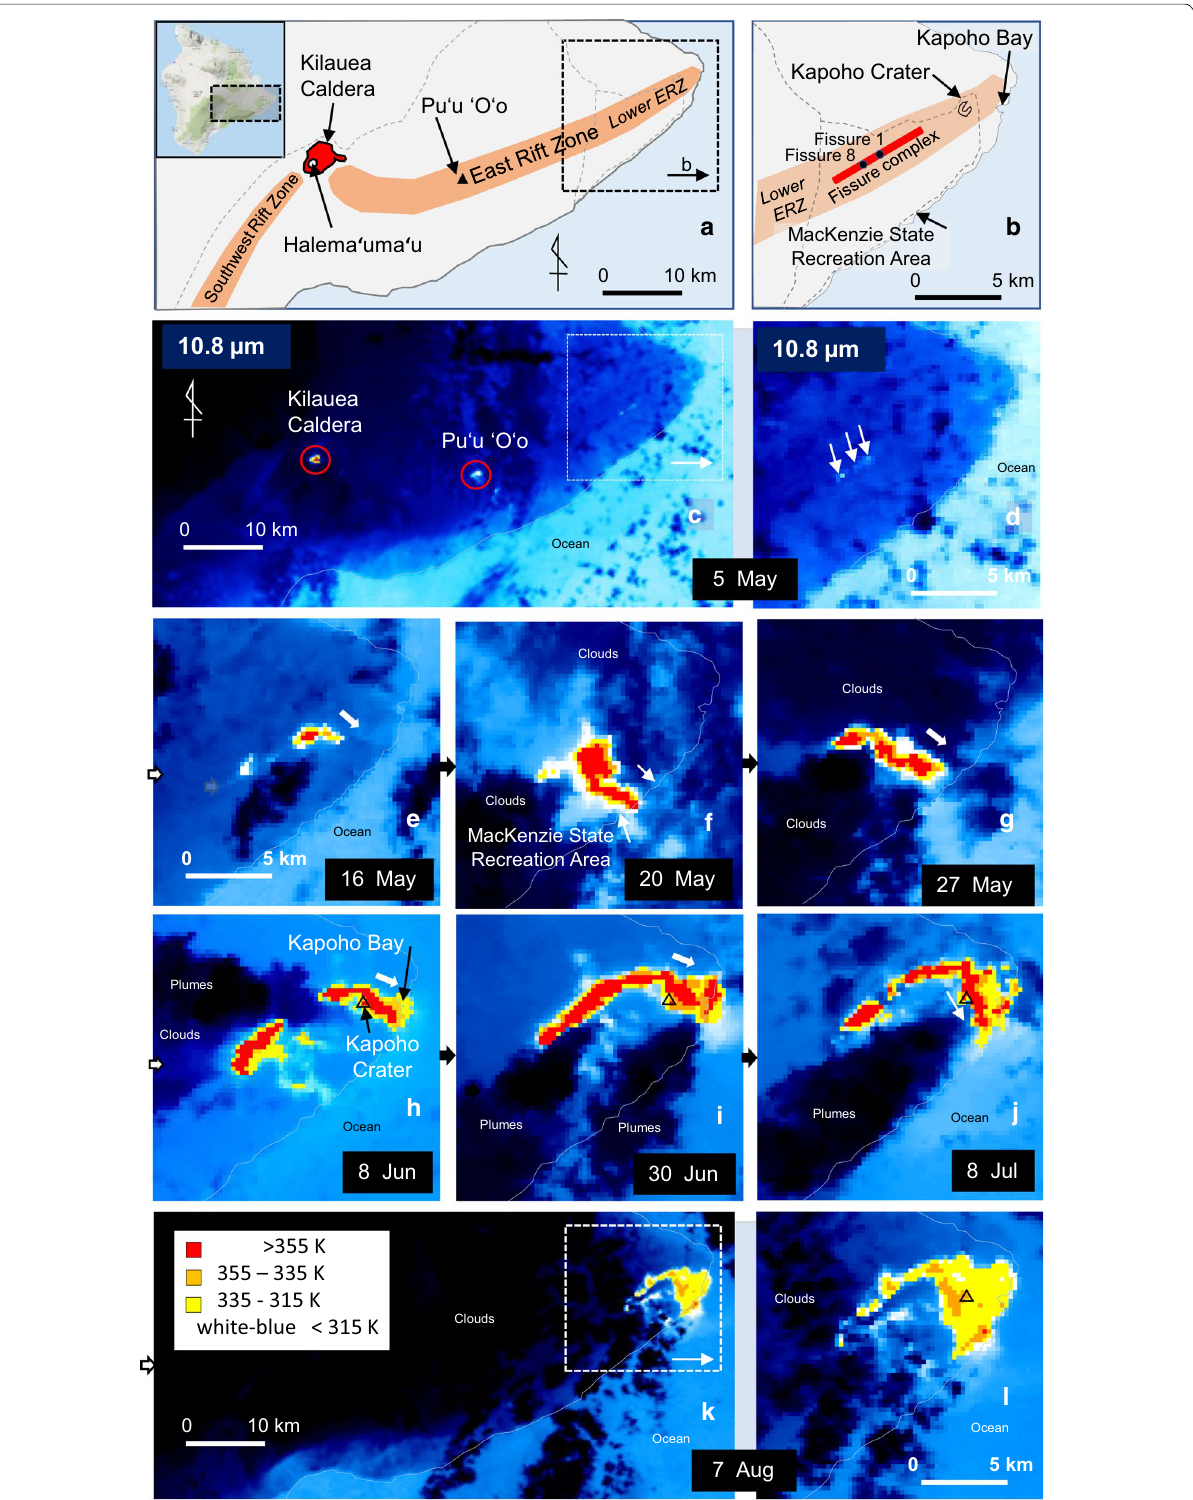
Fig. 2 a Location of the Kilauea Caldera and East Rift Zone. b Lower ERZ and surrounding areas. c – l Eruptive sequence of the 2018 Kilauea eruption observed with 10.8 µm images from the SGLI (pixel-integrated